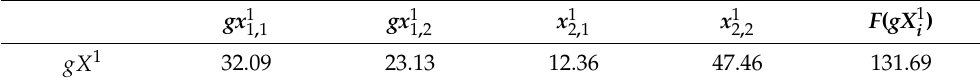
Table 8. Updating the global best solution of this generation gX 1